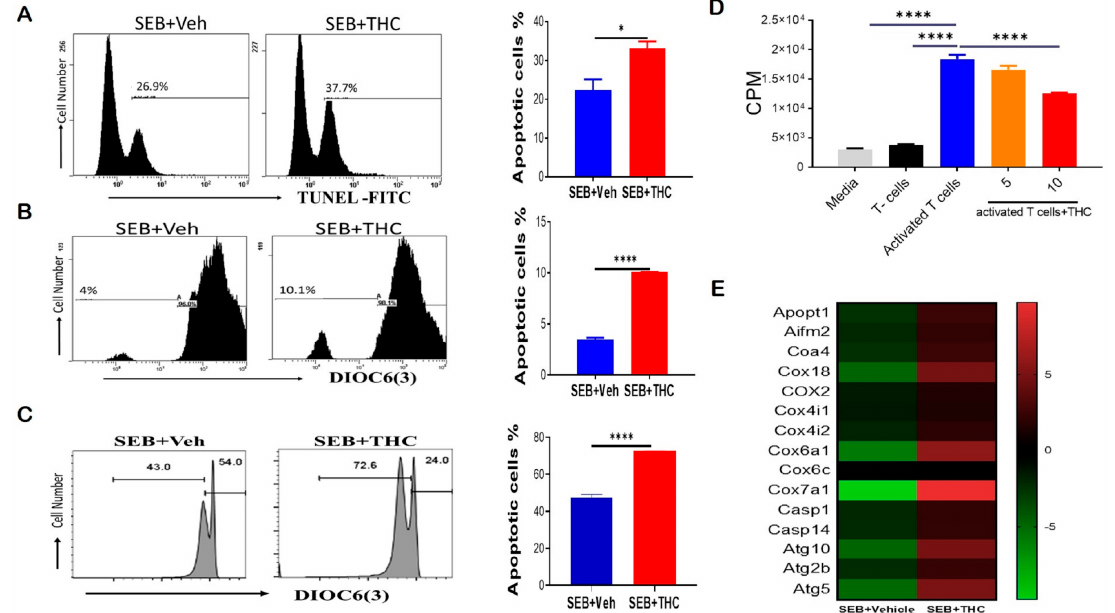
Figure 2. THC attenuates SEB-induced acute respiratory distress syndrome (ARDS) in mice via the induction of apoptosis. For in vivo studies, SEB-mediated ARDS was induced in C3H/HeJ mice, then the mice were treated with either Veh or THC, as described in Methods. For in vitro studies, splenocytes were isolated from naïve mice and activated in culture with SEB+Veh or SEB+THC. ( A ): Terminal deoxynucleotidyl transferase dUTP nick end labeling, TUNEL staining of lung mono-nuclear cells MNCs isolated from SEB+Veh and SEB+THC mice. ( B ): DiOC6(3) staining of CD3+ MNCs isolated from SEB+Veh and SEB+THC mice. ( C ): DiOC6(3) staining of CD3+ splenocytes that were activated in vitro with SEB+Veh or SEB+THC (10 uM). ( D ): 3 H- Thymidine incorporation assay of splenocytes activated in vitro for 72 h with SEB (1 μ g/mL) +Veh or SEB+THC (5 μ m or 10 μ m). Thymidine incorporation is shown as counts per minute (CPM). ( E ): Heatmap of genes associated with apoptosis in SEB+VEH vs. SEB+THC lung MNCs. Vertical bars in panels A-C show data from 5 mice with mean+/-SEM. Statistical significance is depicted as * p < 0.05 and **** p < 0.0001 between the groups.